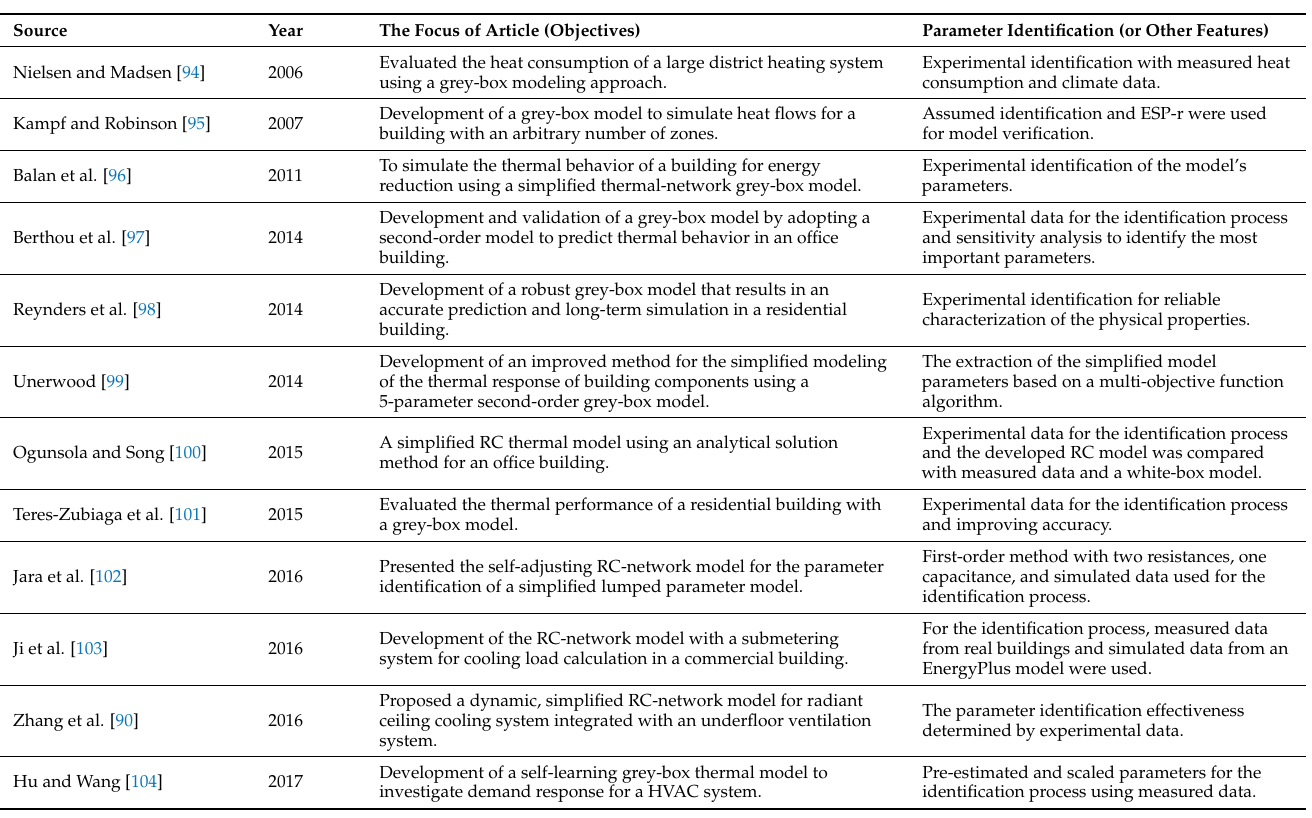
Table 2. List of the representative reviewed papers regarding “grey-box” models for building thermal load and HVAC energy